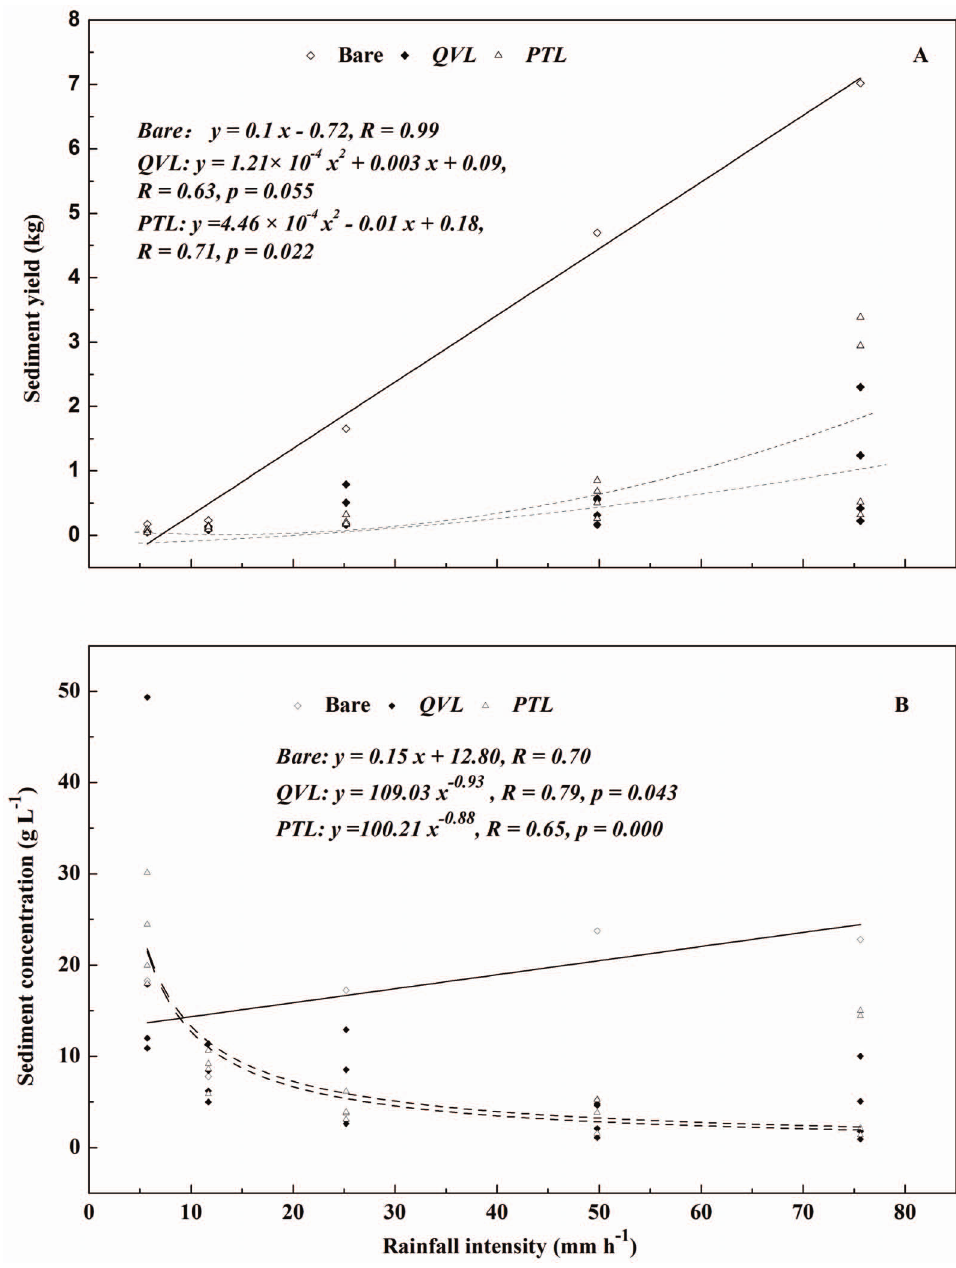
Figure 9. Relationships between sediment yield (A) and sediment concentration (B) versus rainfall intensity for bare-soil plots (open diamonds), Quercusvariabilis litter (closed diamonds), and Pinustabulaeformis litter (open triangles) for four litter